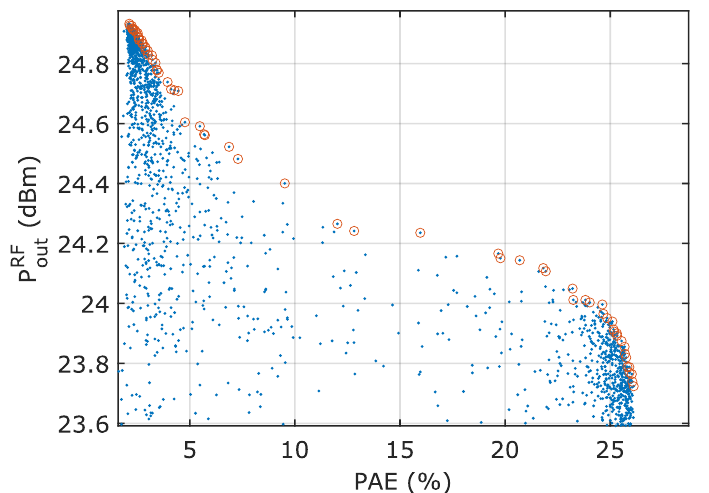
Figure 7. Sampling of the six-dimensional variable space showing many possible trade-off points between RMS RF output power and PAE, highlighting the profile of non-dominated points (Pareto